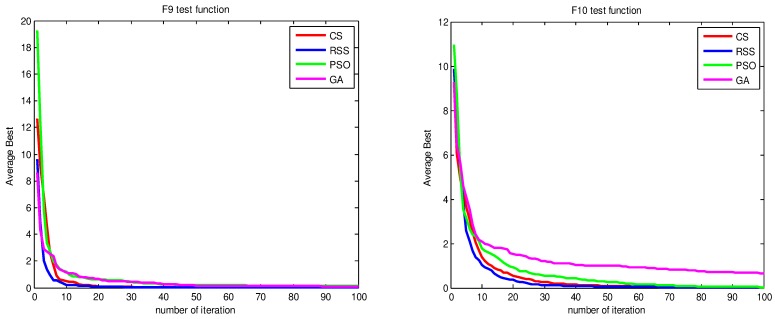
AB convergence of CS, RSS, PSO and GA for minimization of (a) F9 and (b) F10.